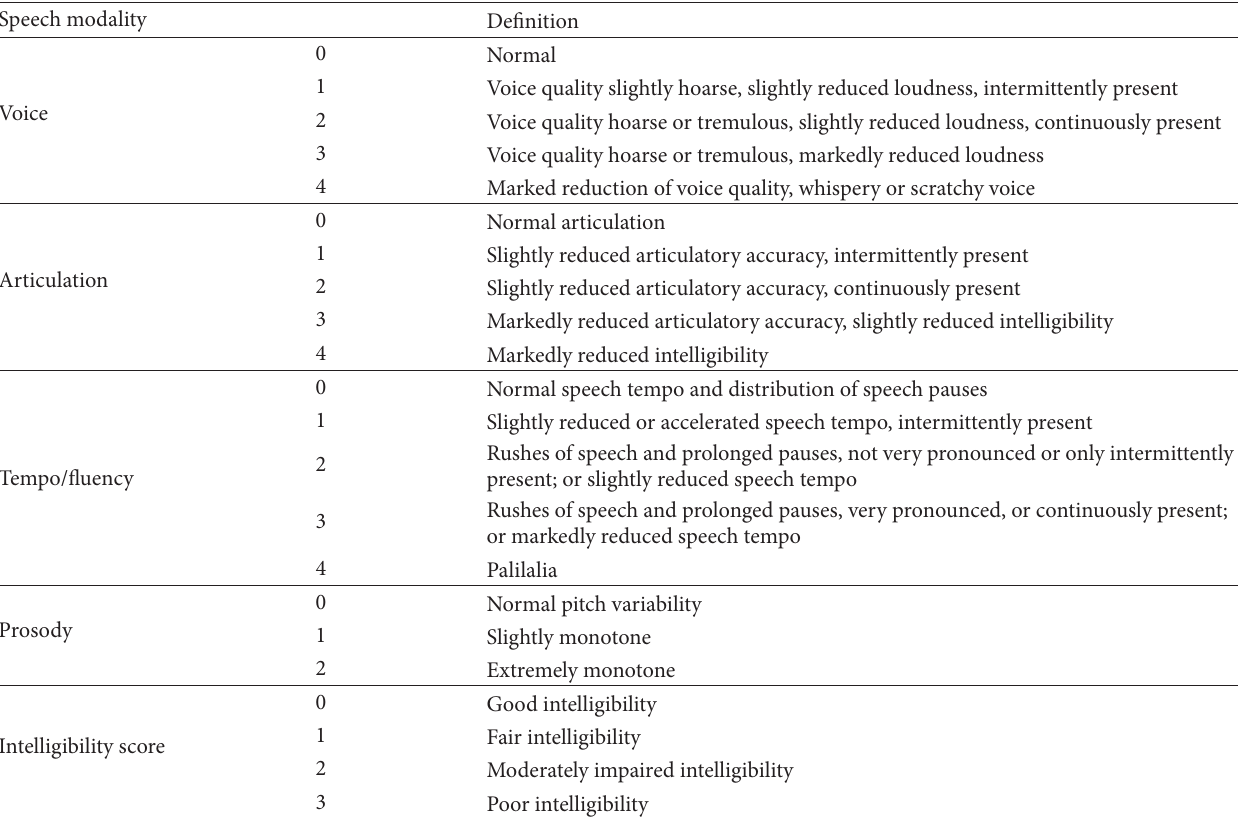
Table 2: Perceptual speech score and intelligibility score.